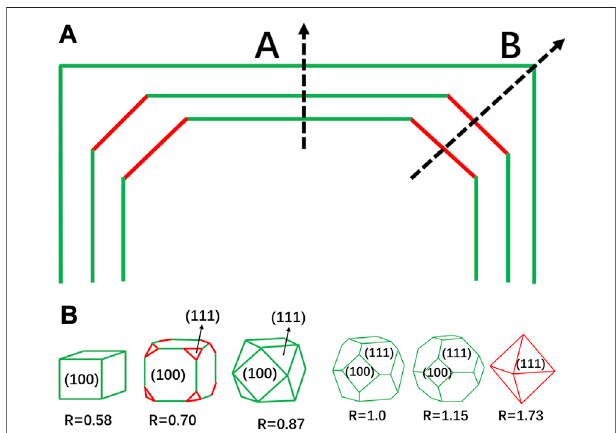
FIGURE 3 | Facets control of metal nanocrystals. (A) The growth rate along the B crystallographic direction is higher than that along the A direction, leading to the disappearance of the B crystallographic facet. (B) Different growth rate ratios will lead to differences in the fi nal crystallographic facet, R is the ratio of < 100 > and < 111 > crystal growth